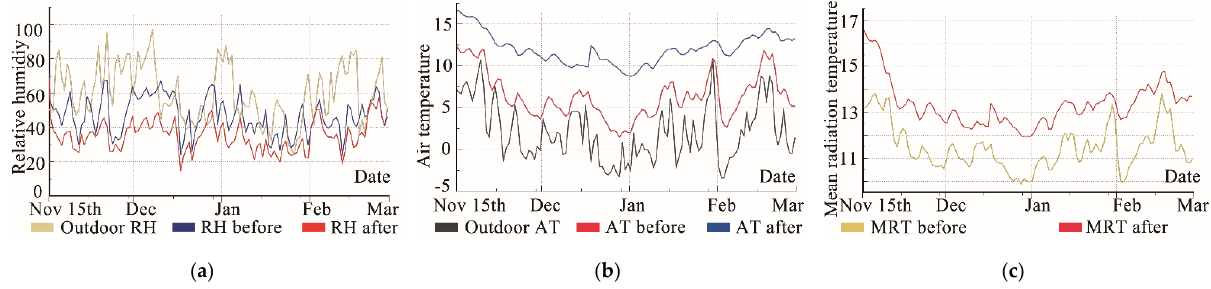
Figure 11. The simulation comparison of physical environment before and after improvement in Bedroom D in winter. ( a ) The simulation comparison of indoor humidity before and after improvement in winter, ( b ) The simulation comparison of the indoor air temperature before and after improvement in winter, ( c ) The simulation comparison of the mean radiation temperature before and after improvement in winter.